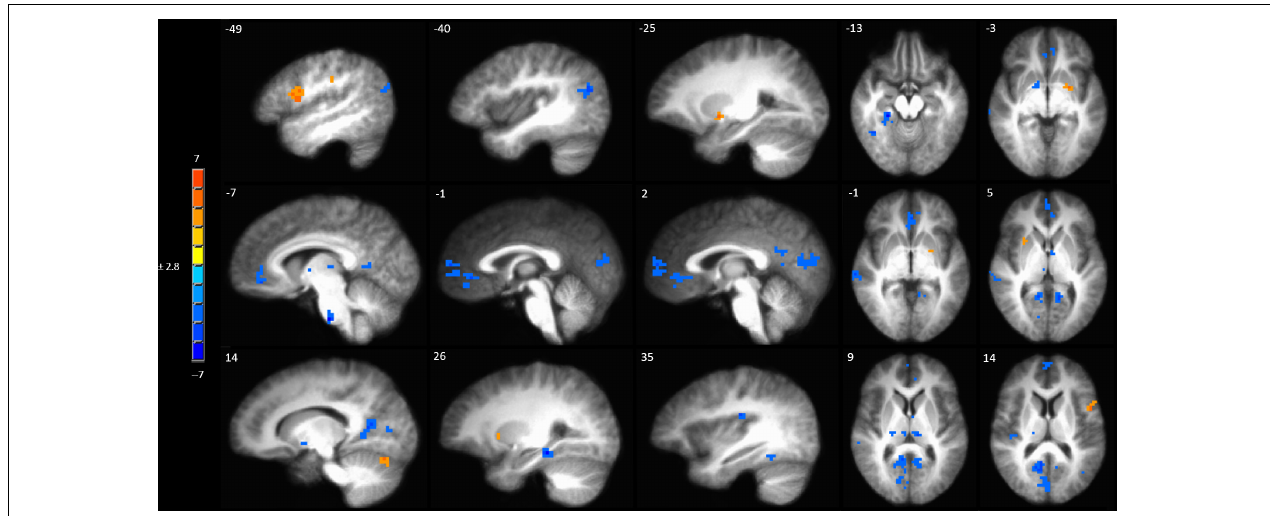
FIGURE 4 | Contrast map of mechanical pain-related activation during the sham tDCS session where post-C-HP > pre-C-HP. Maps are voxel-wise cluster extent corrected threshold of p ≤ 0.005. Coordinates are according to the Talairach atlas.